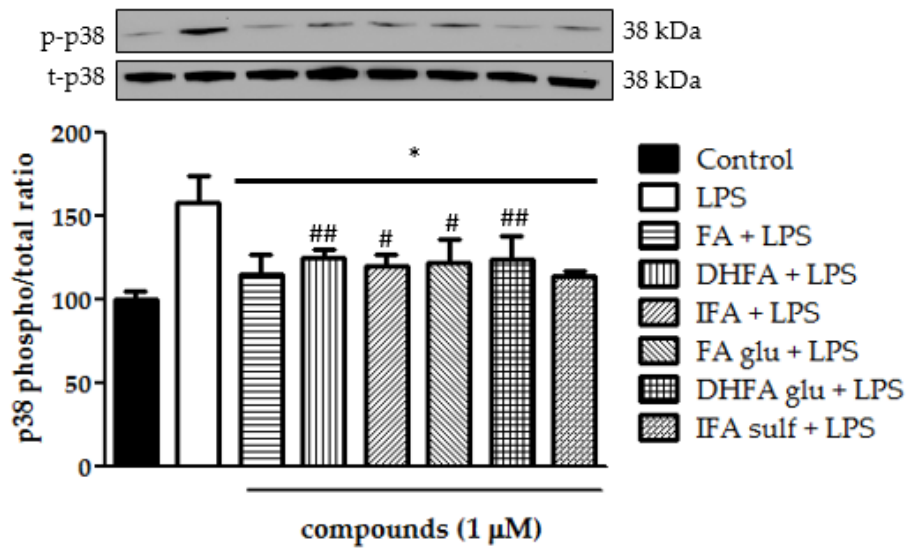
Figure 8. Modulation of MAPK p38 reported as a percentage of the control phospho p38/total p38 ratio in Caco-2 cells treated with LPS (1 µ g/mL) for 2 h and pretreated for 30 min with FA, DHFA, IFA, FA glu, DHFA glu, and IFA sulf (1 µ M) preceding LPS co-exposure. Control and LPS groups were pretreated with an equivalent volume of methanol. Each column represents the mean ± SD of the independent experiments ( n = 6). Significant differences among groups are described using different superscript symbols; * = significant vs. LPS ( p < 0.001); # = significant vs. control ( p < 0.05); ## = significant vs. control ( p < 0.01). Representative WB picture of the experiment is shown.